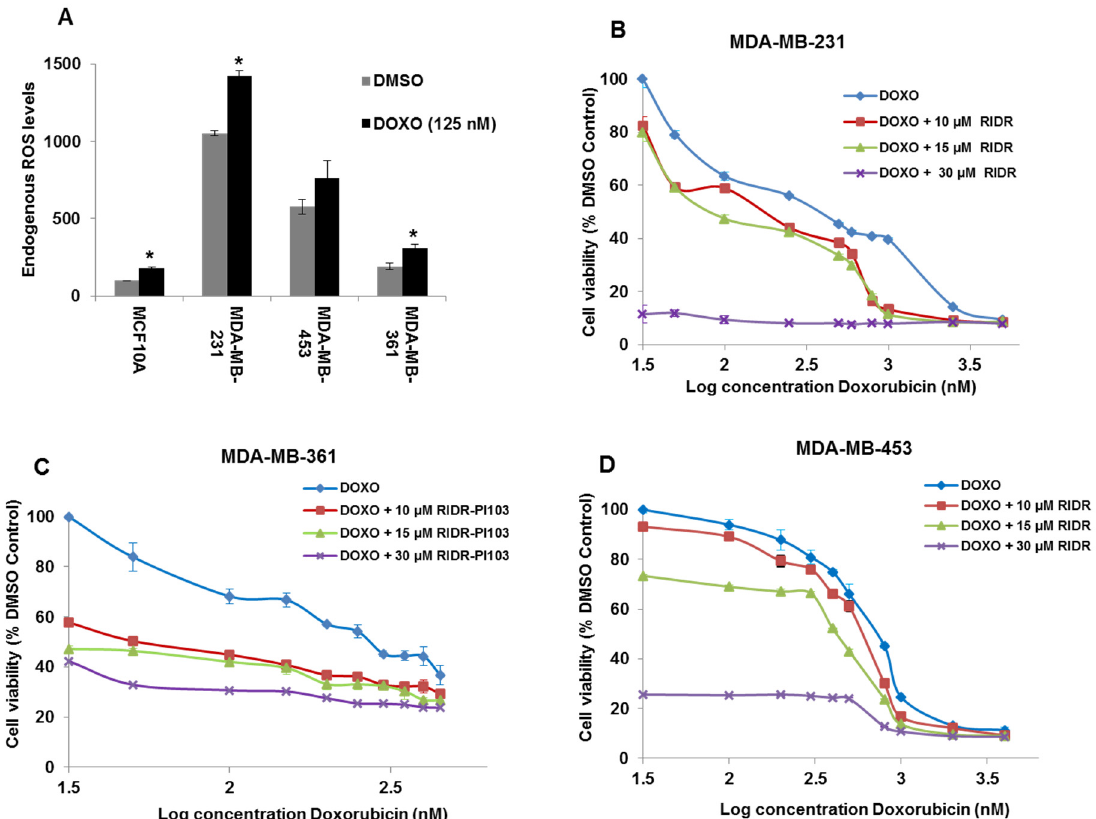
Figure 2. Doxorubicin induces ROS and combination of RIDR-PI-103 and Doxorubicin inhibit breast cancer cell viability. ( A ) Reactive oxygen species (ROS) levels were measured by DCFDA assay where MCF10A, MDA-MB-231, MDA-MB-361 and MDA-MB-453 cells were treated with or without 125 nM doxorubicin (DOXO) for 30 min. Dimethyl sulfoxide (DMSO) was used as vehicle control. Results are represented as mean ± SEM from 3 biological triplicates and represented graphically. * indicates p < 0.05 compared to DMSO treatment. ( B ) MDA-MB-231 cells (2 × 10 4 cells/well) were seeded in 96 well plates in triplicate and treated with a serial concentration of doxorubicin (DOXO) in presence of 10 µ M, 15 µ M and 30 µ M RIDR-PI-103 (RIDR) for 72 h. The concentration of doxorubicin used was 500–5000 nM for MDA-MB-231. ( C ) MDA-MB-361 cells (2 × 10 4 cells/well) were seeded in 96 well plates in triplicate and treated with a serial concentration of doxorubicin (DOXO) in presence of 10 µ M, 15 µ M and 30 µ M RIDR-PI-103 (RIDR) for 72 h. The concentration of doxorubicin used was 50–450 nM for MDA-MB-361. ( D ) MDA-MB-453 cells (2 × 10 4 cells/well) were seeded in 96 well plates in triplicate and treated with a serial concentration of doxorubicin (DOXO) in presence of 10 µ M, 15 µ M and 30 µ M RIDR-PI-103 (RIDR) for 72 h. The concentration of doxorubicin used was 100–4000 nM for MDA-MB-453. All the cells were treated with MTT (5 mg/mL) for 4 h and absorbance read at 570 nm in a microtiter plate reader ( n = 3 independent experiments performed in triplicate ±